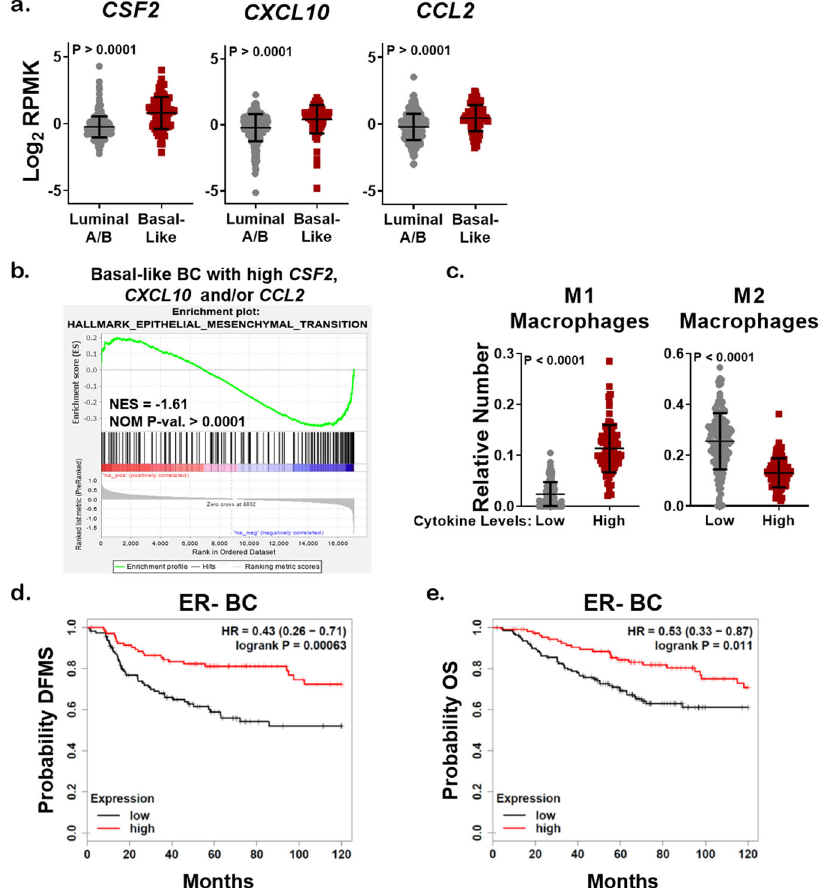
Fig. 5 Cytokines upregulated by miR-200c restoration predict enhanced survival of TNBC patients. a mRNA expression of cytokines as curated by the Nature 2012 dataset in cBioPortal for luminal A/B ( N = 321) or basal-like BC specimens ( N = 81). Student ’ s unpaired two-tailed t test. b Genes enriched in basal-like BC specimens with expression of CSF2 , CXCL10 , and CCL2 according to the dataset in a were subjected to GSEA analysis (Hallmark), normalized enrichment score (NES), nominal p value (NOM p -val). c mRNA pro fi ling as curated by the Firehouse Legacy dataset (TCGA) was assessed for the relative number of immune in fi ltrates using CIBERSORT. Specimens with expression of CSF2 , CXCL10 , and/or CCL2 in the lowest quartile (low, N = 92) or highest quartile (high, N = 132) were strati fi ed via the relative number of M1 or M2 macrophages. Shown is the mean number of predicted immune cells ± s.d., Student ’ s unpaired two-tailed t test. KM plotter was used to stratify ER − BC patients with high expression of CSF2 , CXCL10 , and CCL2 (red) based on distant metastasis-free survival (DMFS, d , N = 218) and overall survival (OS, e , N =